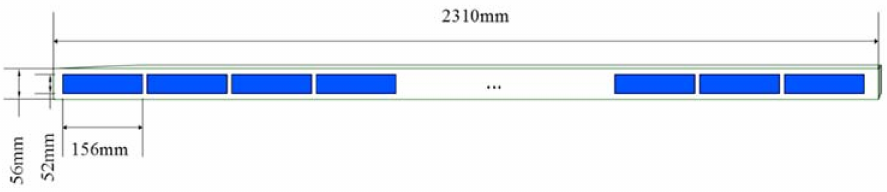
Figure 12. Standard Solarus collector absorber.